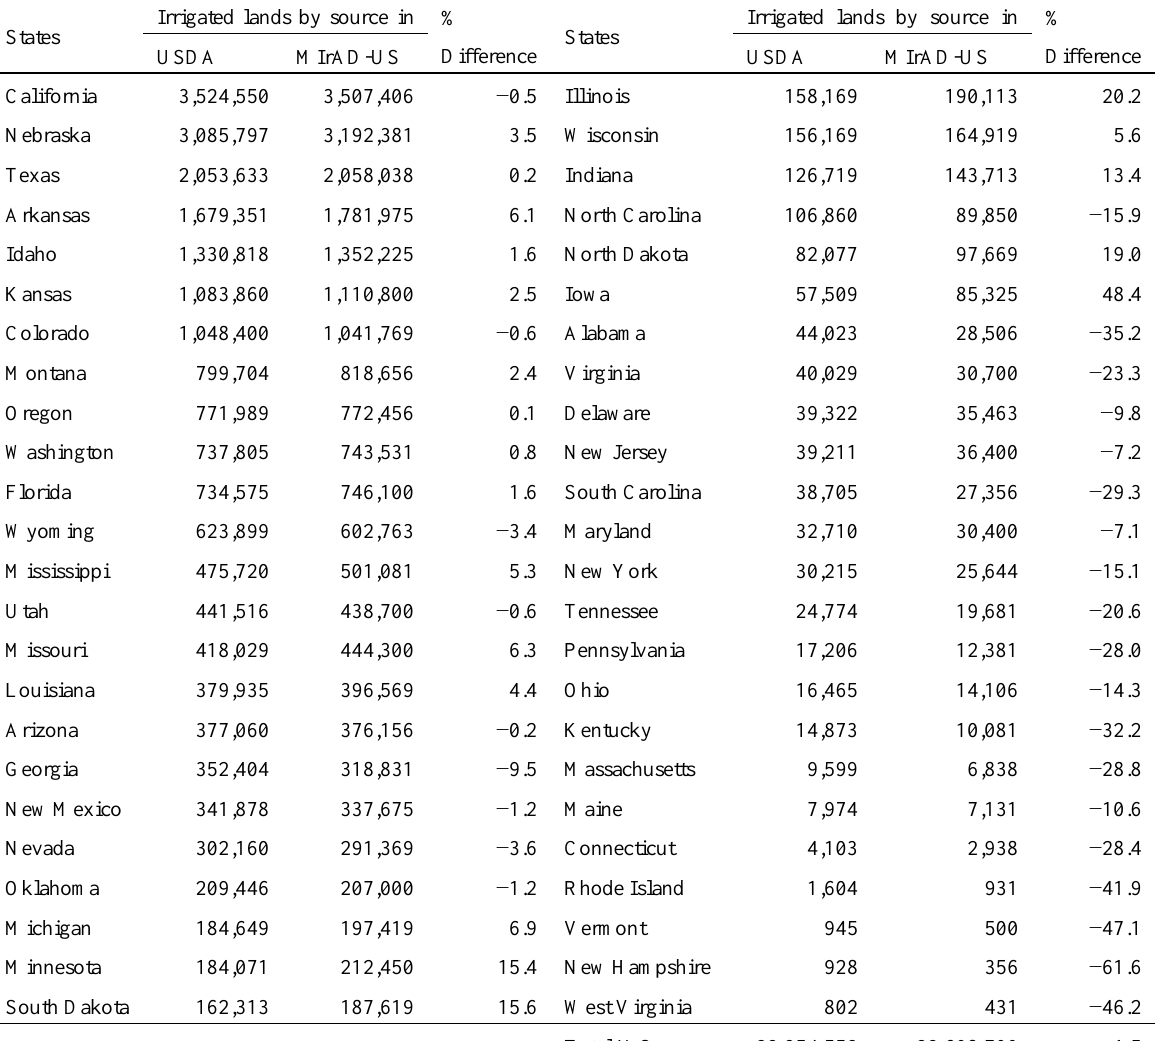
Table 1. Irrigated area estimates of USDA and MIrAD-US by state for